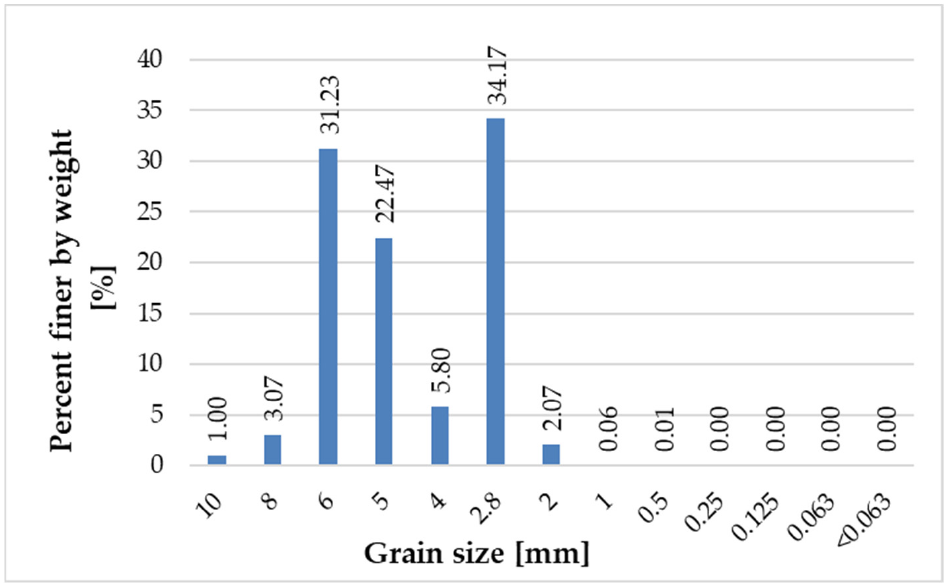
Figure 7. Grain size representation of recycled glass fraction 1/4 mm.